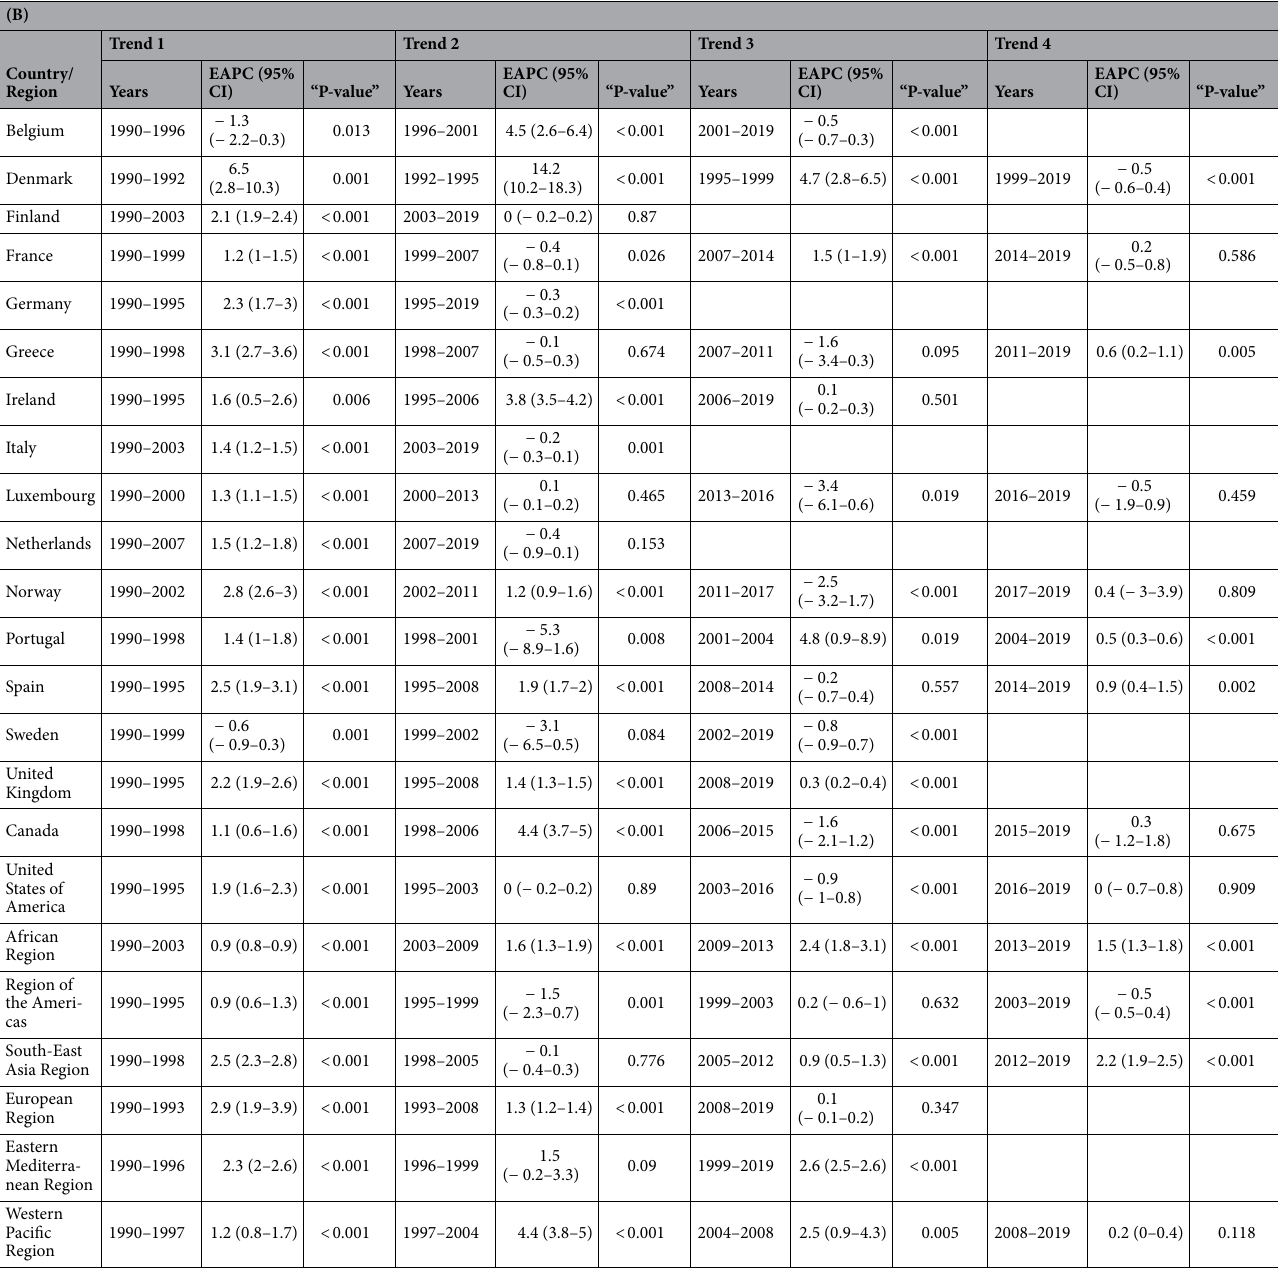
Table 3. Joinpoint analysis for KC age-standardized incidence rates in EU15 + countries and WHO regions for years 1990–2019 in males (A), females (B). EAPC indicates estimated annual percentage change, with 95% confidence intervals in brackets. *Significantly different from 0 (P < 0.05). AAPC (Average annual percentage change) indicates summary measure of the trend over